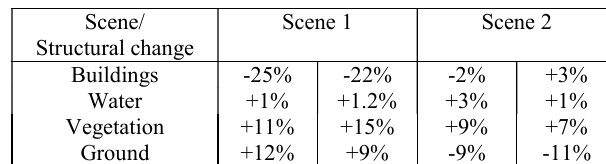
Figure 5 . Image-based histograms as resulting from Figure 3. (a) QuickBird image of “Scene 1”. (b) WorldView image of “Scene 1”. (c) QuickBird image of “Scene 2”. (d) WorldView image of “Scene 2”. The y-axis shows frequency while the x- axis numbers 1-4 denote buildings, vegetation, water and ground, respectively.